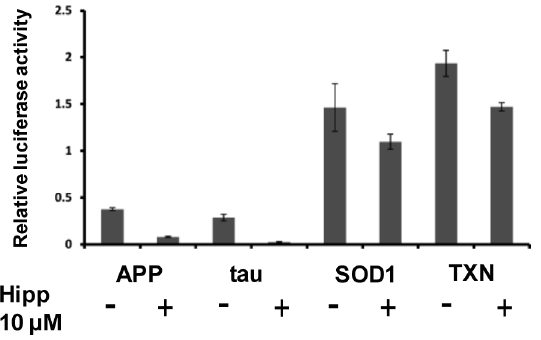
Figure 4. Translational inhibition of APP and tau is mediated via the 5 9 UTR. Firefly luciferase reporter plasmids containing the 5 9 UTR of APP, tau, SOD1 or TXN upstream of a destabilized firefly luciferase open reading frame were transfected into SH-SY5Y cells + / 2 10 m M hippuristanol. The dramatic reduction of luciferase expression in the APP and tau 5 9 UTR constructs following hippuristanol treatment is not mirrored by the SOD1 and TXN 5 9 UTR containing plasmids. Luciferase activity was normalized to a cotransfected Renilla control reporter and means and standard errors of at least three replicates are shown.